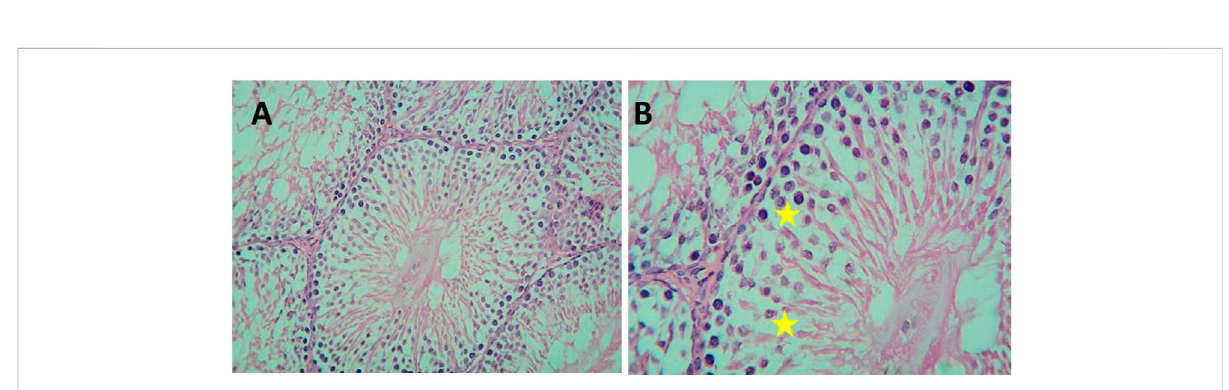
FIGURE 12 MicrographofGin-treatedalbinoratshowinglesscrowdedspermatogeniccellsthannormalcontrolwithsomespacesbetweenthecells(H&E; (A) -X200, (B)